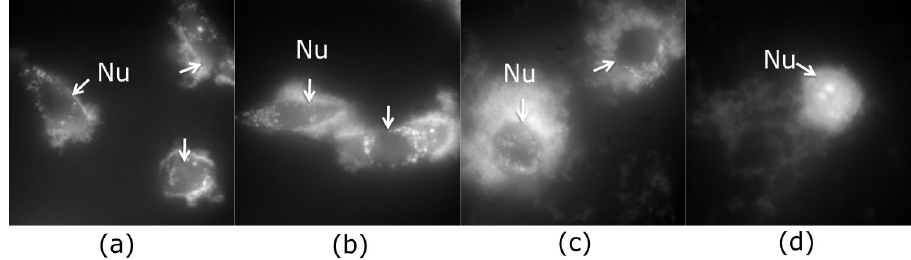
Figure 5. Fluorescent imaging of L929 cells exposed to QCDs for 24 h: ( a ) 50 µ g/mL; ( b ) 100 µ g/mL; ( c ) 200 µ g/mL; ( d ) 400 µ g/mL—dead cell with QCDs inside the nucleus and nucleoli; “Nu” and arrows denotes the nuclei. FMS, field of view 91 µm.